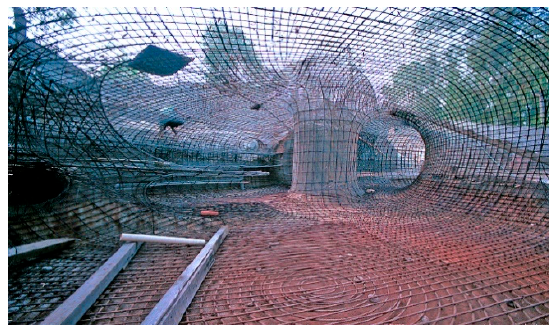
Figure 1. Internal structure based on anti-seismic rods.